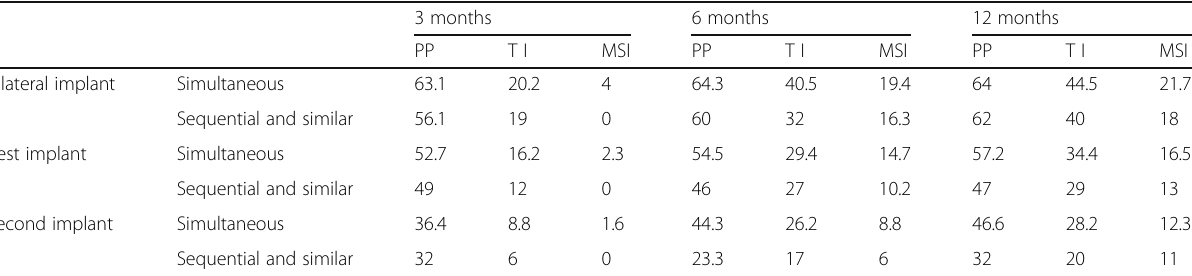
Table 6 Average scores of ESP test for peri-lingual